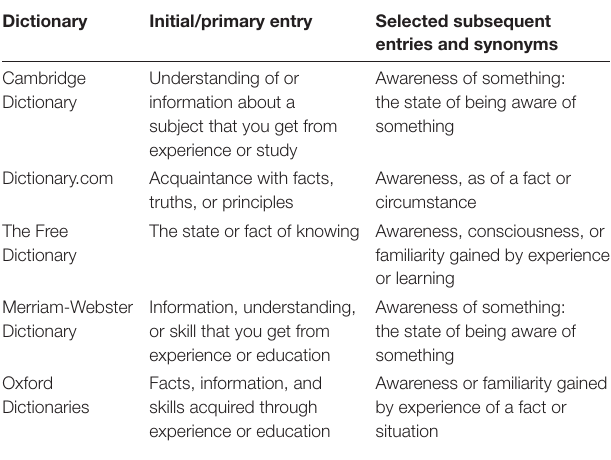
tAble 1 | Dictionary entries concerning